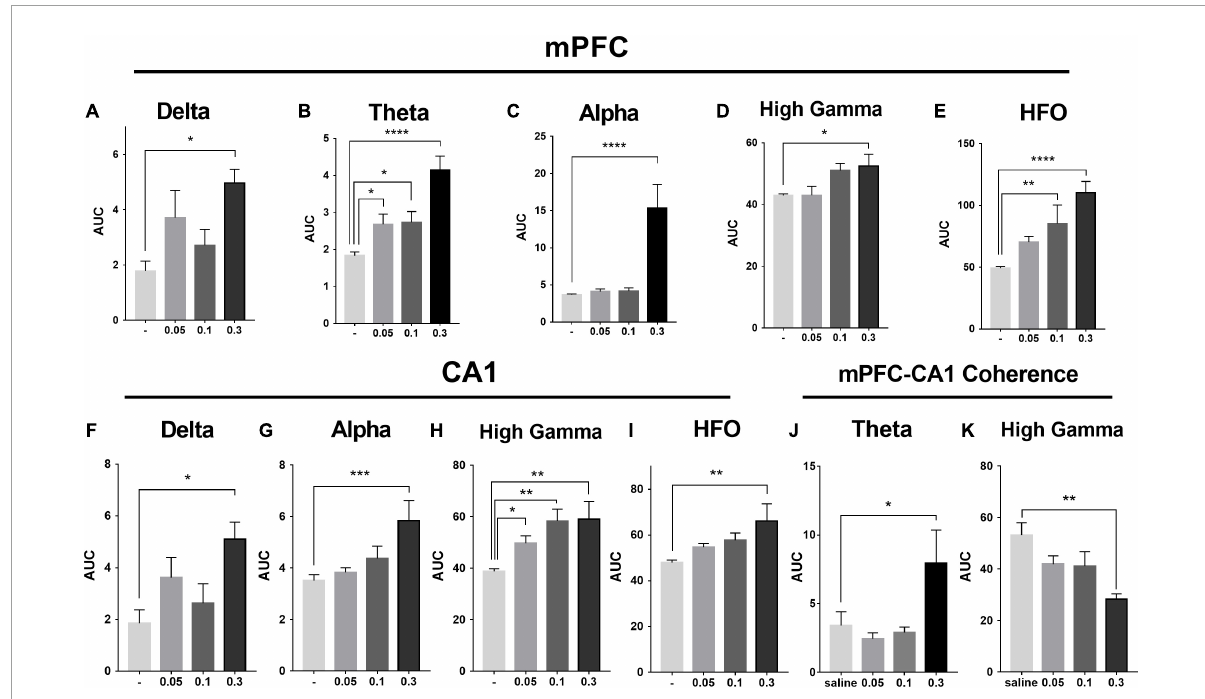
FIGURE5 Effects of MK-801 on the area under the curve (AUC) of each LFP power in the prefrontal lobe and hippocampus. The up row displayed AUC values of the mPFC for 30–60 min. after drug administration in transitions of delta power (1–4 Hz; A ), theta power (6–8 Hz; B ), alpha power (8–12 Hz; C ), high gamma power (60–100 Hz; D ), and HFO power (150–200 Hz; E ). The down row displayed AUC values of the CA1 for 30–60 min. after drug administration in transitions of delta power (F) , alpha power (G) , high gamma power (H) , and HFO power (I) . The data represented the mean ± SEM obtained from 4 to 8 animals per group. *, **, *** and **** indicated p < 0.05, p < 0.01, p < 0.001, p < 0.0001 compared to the vehicle. Theta (J) and gamma (K) power coherence between mPFC and CA1 under saline and MK-801 (0.05, 0.1, and 0.3 mg/kg) condition during 30–60 min.